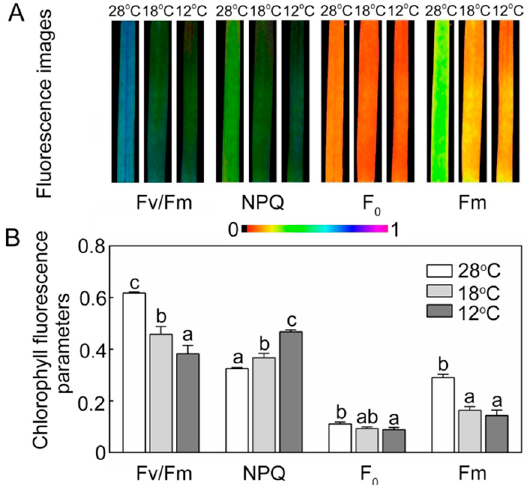
Figure 8. E ff ect of chilling stress on chlorophyll fluorescence parameters of rice seedlings. The chlorophyll fluorescence images ( A ) and chlorophyll fluorescence parameters (Fv / Fm, NPQ, F 0 , Fm) ( B ) after 48 h of greening. Six day old etiolated seedlings were treated with 18 ◦ C or 12 ◦ C chilling stress. Values are means ± SD from three independent biological replicates. Di ff erent letters indicate significant di ff erences according to Duncan’s multiple range tests ( p < 0.05